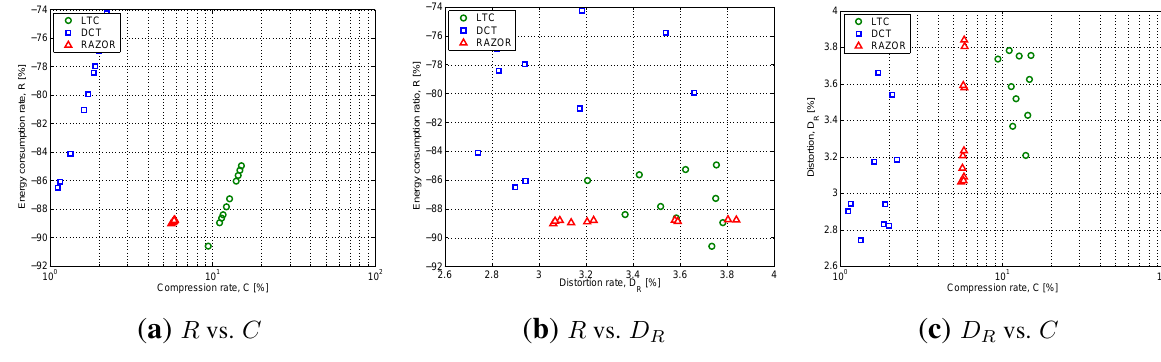
Figure 6. Performance comparison of three data compression solutions: RAZOR, in red with triangular markers, LTC, in green with round markers, and DCT, in blue with square markers. The three algorithms have been compared using three metrics: the compression rate, C , the energy consumption ratio, R , and the distortion, D . The signals used in the R graph are those of the SYN dataset, varying the correlation length from 20 to 200